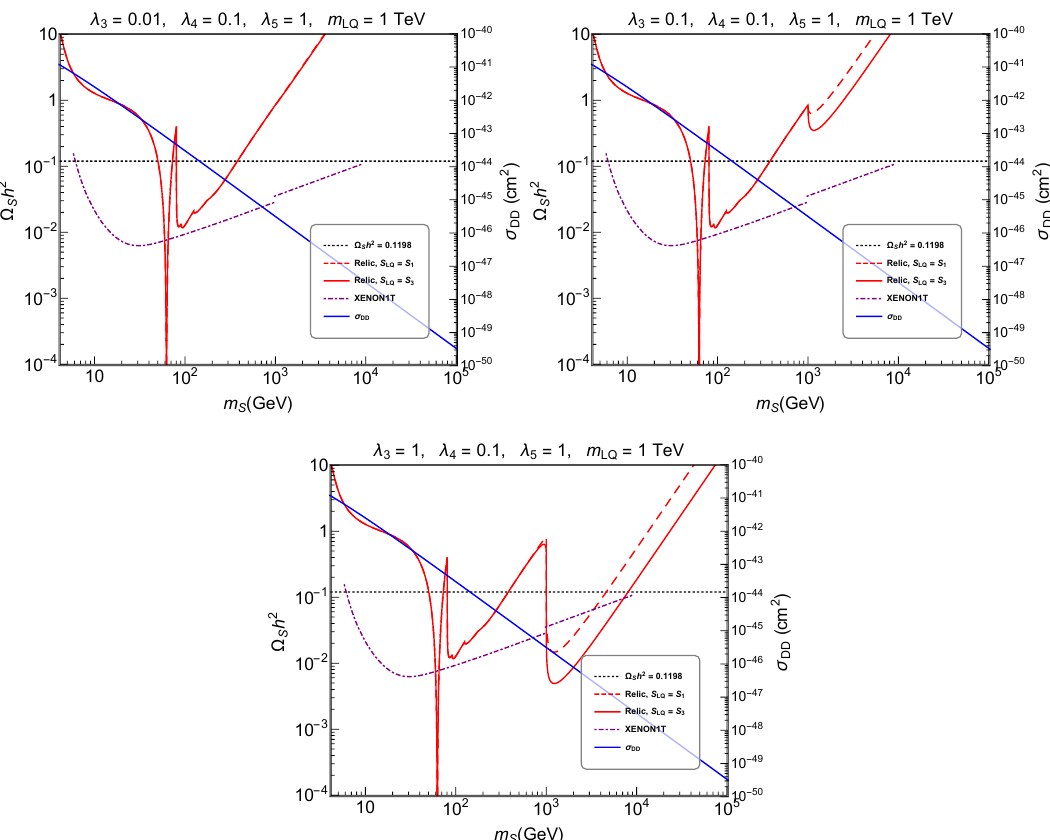
Figure 6 . Dark matter relic density as a function of m S in red solid (dashed) lines for triplet (singlet) scalar leptoquarks. DM-nucleon scattering cross section and XENON1T bound are shown in blue line and purple dot-dashed line, respectively. (cid:21) 3 = 0 : 01 ; 0 : 1 ; 1 are taken from the top left plot clockwise, and (cid:21) 4 = 0 : 1, (cid:21) 5 = 1 and m LQ = 1 TeV are taken for all